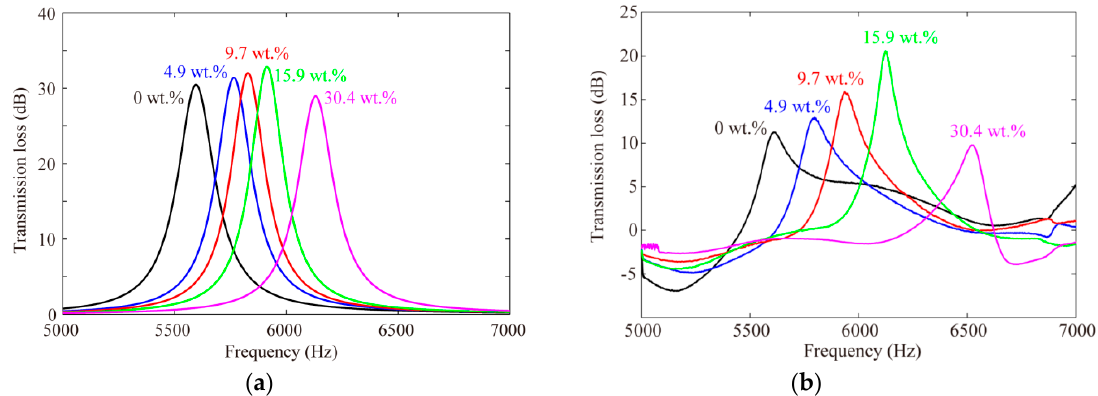
Figure 3. Spectrum of transmission loss under different glucose concentrations. ( a ) Analytical results; ( b ) experimental results.